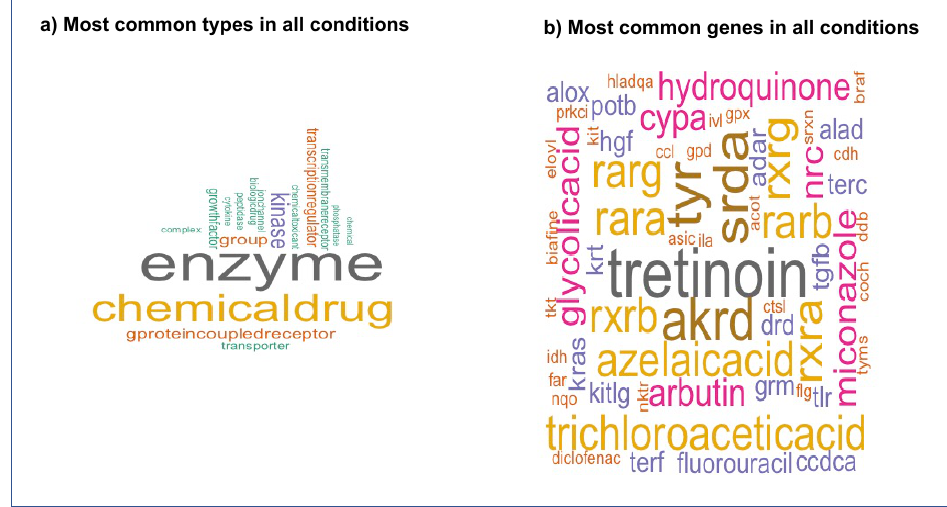
Figure 3. Word cloud shows the most common types and genes for all conditions based on TF/IDF.